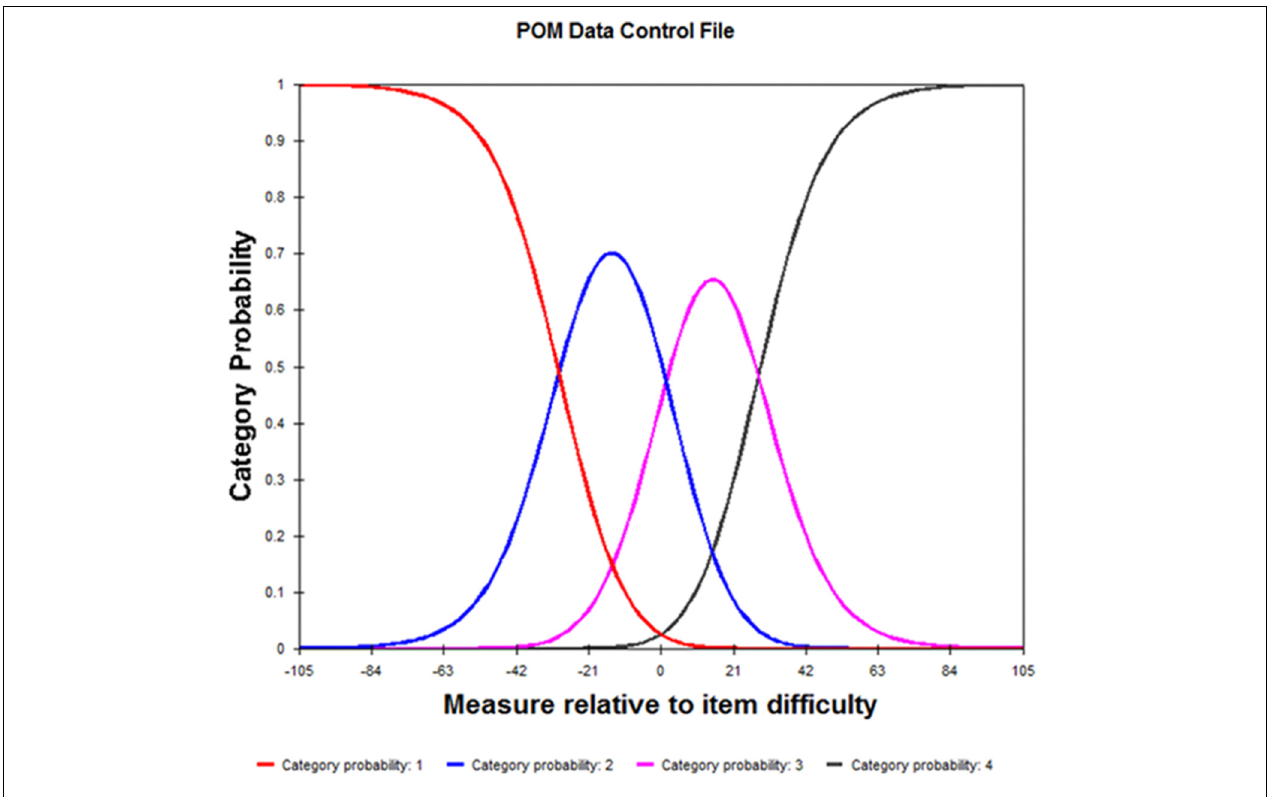
FIGURE 1 | Rating scale